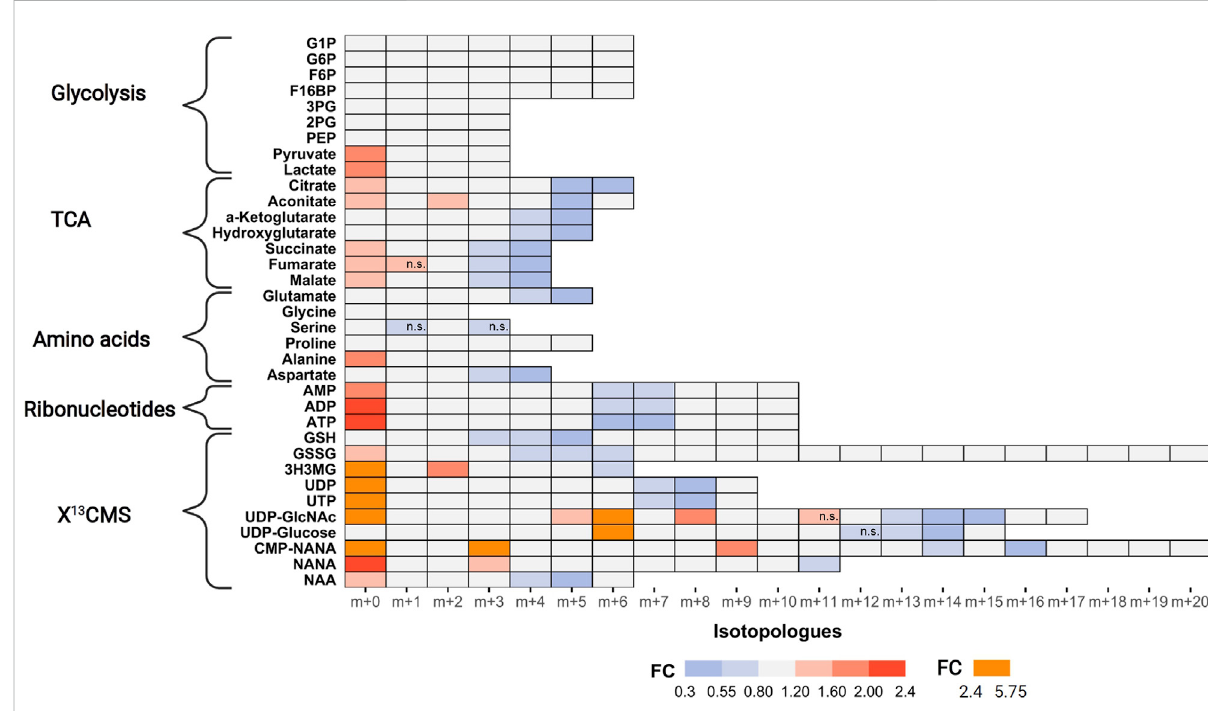
FIGURE 4 Impact of AZD8186 treatment on 13 C tracer incorporation into different metabolic pathways. MDA-MB-468 cells were cultivated in RPMI with [U- 13 C] glucose and treated with 0.5 µM AZD8186 or vehicle for 24 h. Fold changes (AZD8186 vs. vehicle) of the individual isotopologues were calculated from the average labeling fraction of three technical replicates per condition and are represented by the indicated colour code. Only effects are displayed in the heatmap that exhibit a FC < 0.8 and > 1.2 and tracer incorporation > 3% (average of labeling fraction in control and treatmentgroup).Informationonalterationsofisotopologuesthatdonotful fi lltheseFClimitsaswellasinformationonresultsfromstatisticaltesting (adjusted p -value;Welch ’ s t test)canbeobtained fromSupportingPDF.Isotopologuesthatarenotsigni fi cantlyaltered areindicated(n.s.).Fractional abundance information is provided in Supplementary Table S2. G1P, Glucose-1 phosphate; G6P, Glucose-6 phosphate; F6B, Fructose-6,- phosphate; F16BP, Fructose-1,6,-bisphosphate; 3 PG, 3-Phosphoglycerate; 2 PG, 2-Phosphoglycerate; PEP, Phosphoenolpyruvate; 3H3MG,